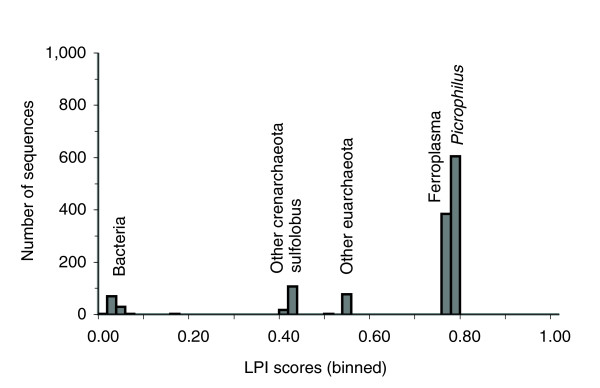
LPI score distribution histogram for T. acidophilum. Filter threshold setting was zero.